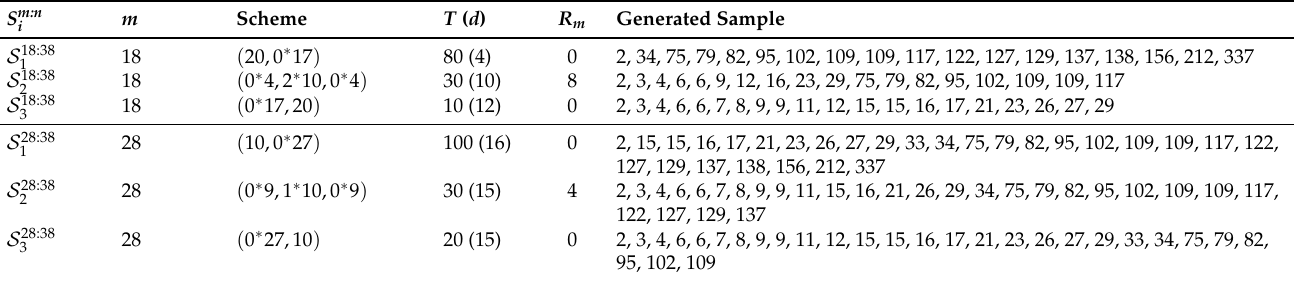
Figure 5. ( a ) Contour plot of β and θ and ( b ) fitted/empirical RFs (right panel) from MTS data. Table 1. Different AP-II-HC samples from MTS